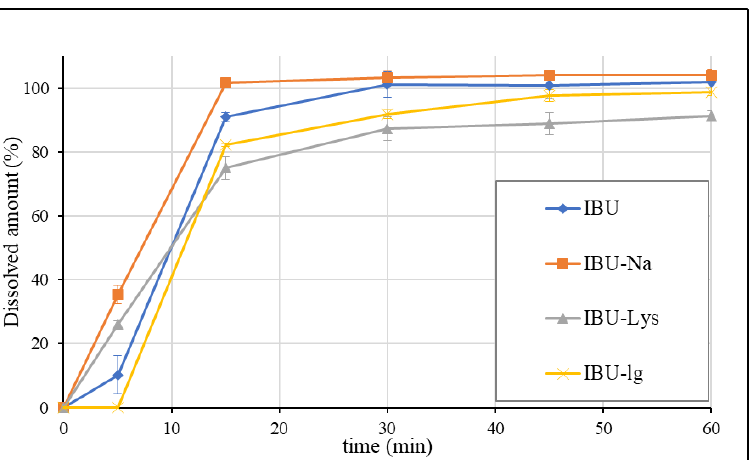
Figure 3. Dissolution results of ibuprofen formulations obtained by USP method.